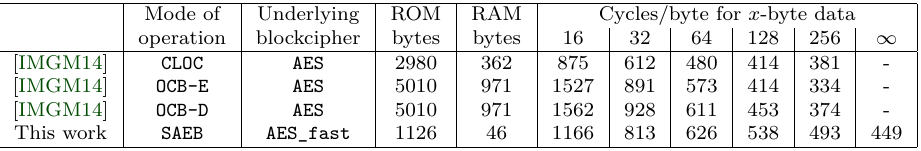
Table 4: Performance comparison with existing AEAD